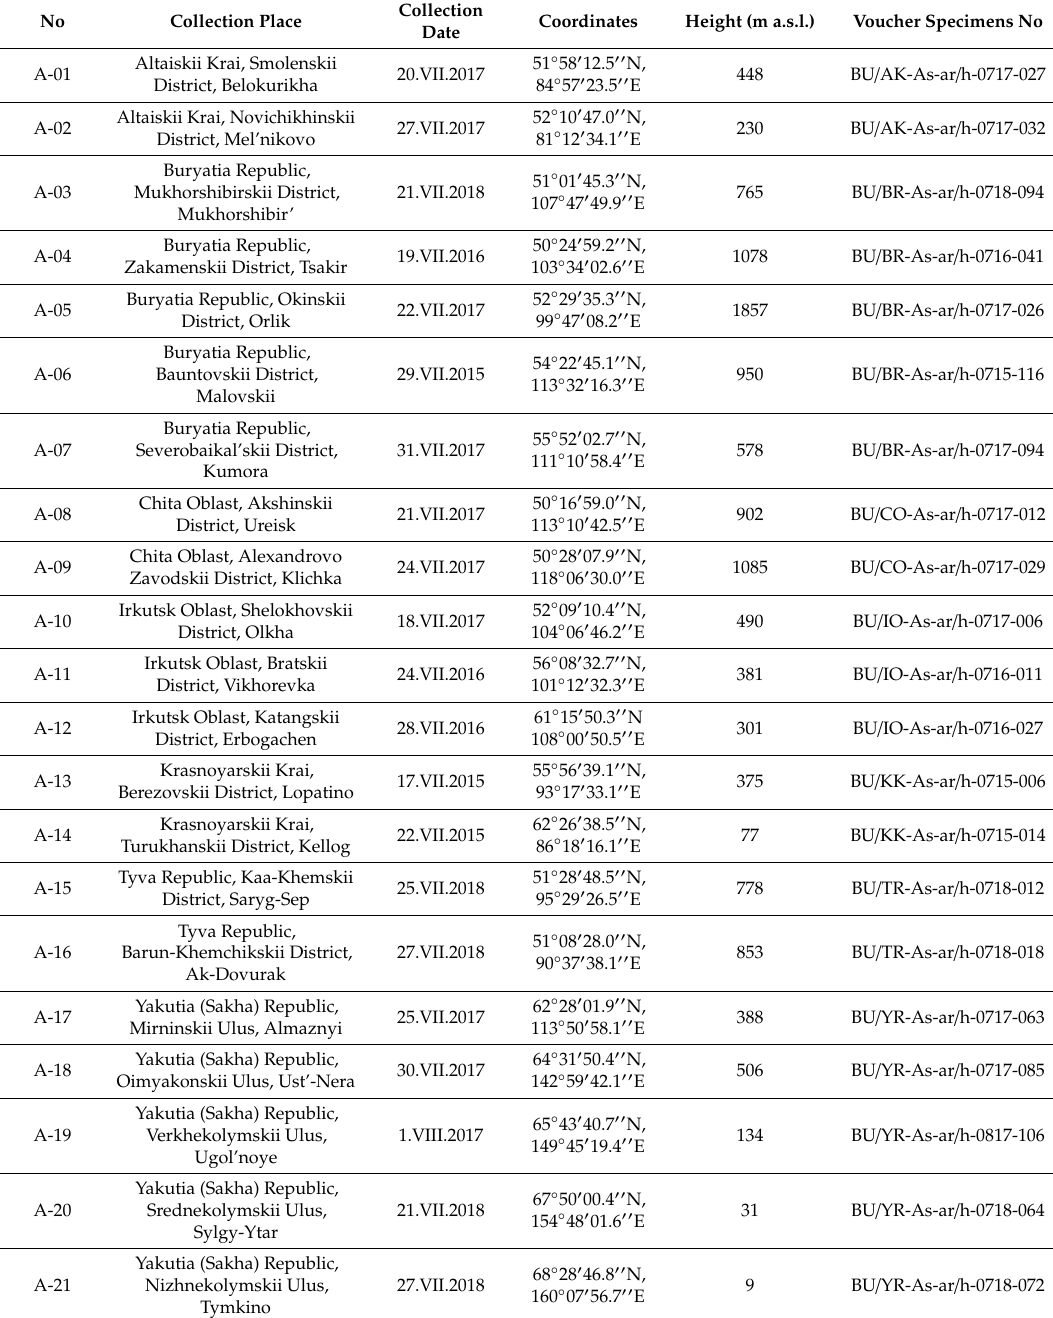
Table 1. Detailed information of Artemisia frigida